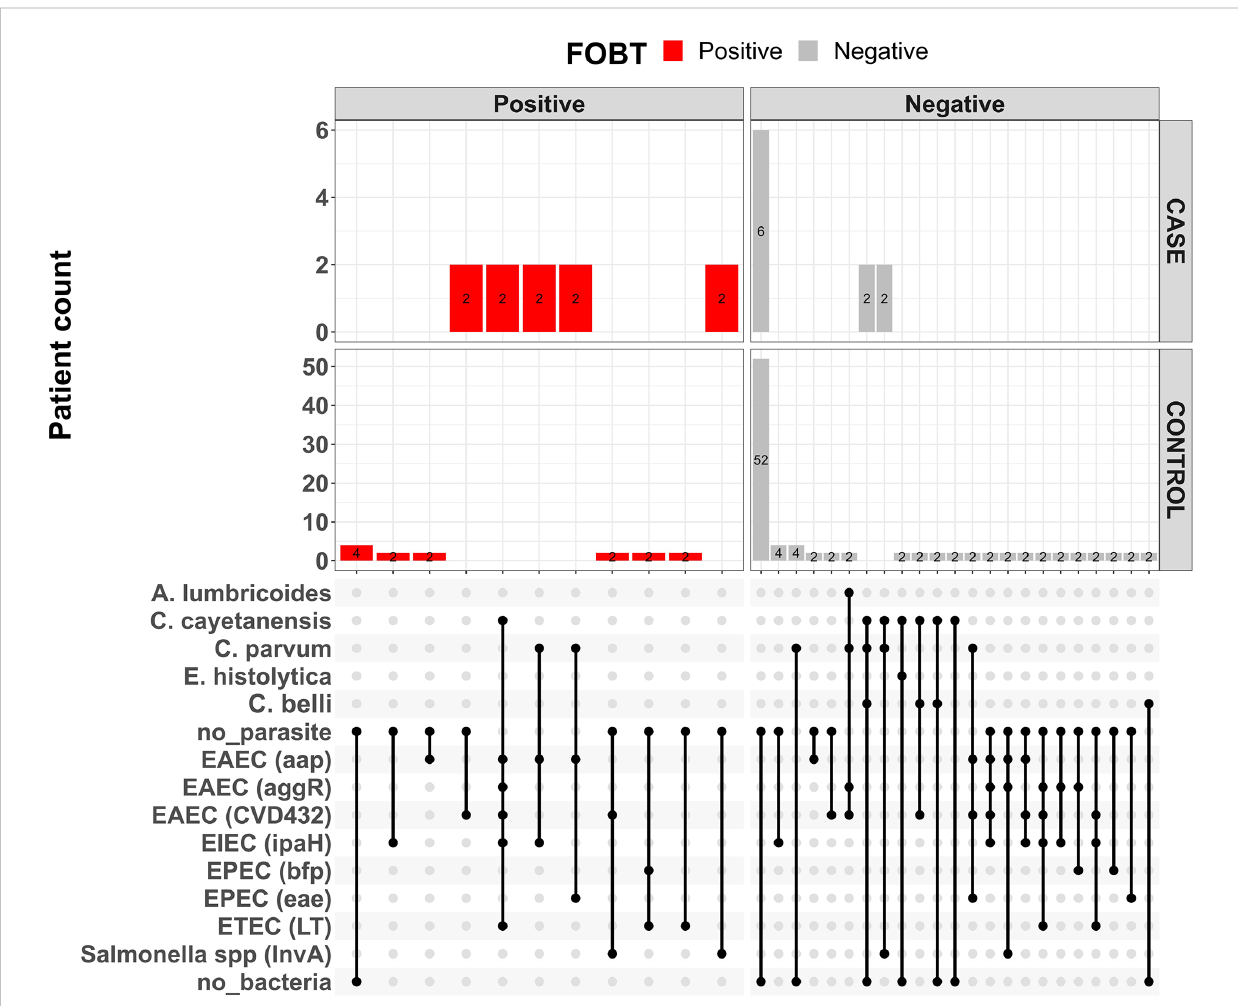
FIGURE 1 Upsett plot showing pathogen combinations for co-infections and faecal occult blood status among children living with HIV (cases) and HIV- uninfected children